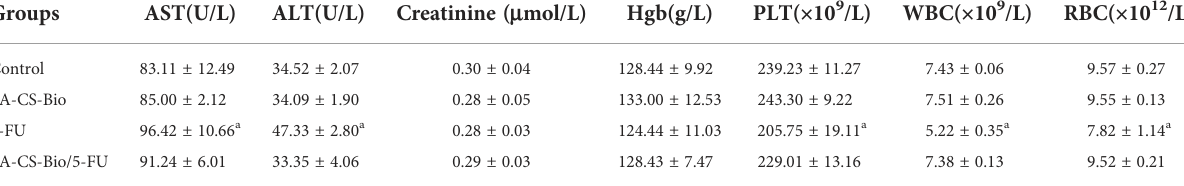
TABLE 4 Toxic and side effects of FA-CS-Bio/5-FU nanoparticles on tumor-bearing mice.